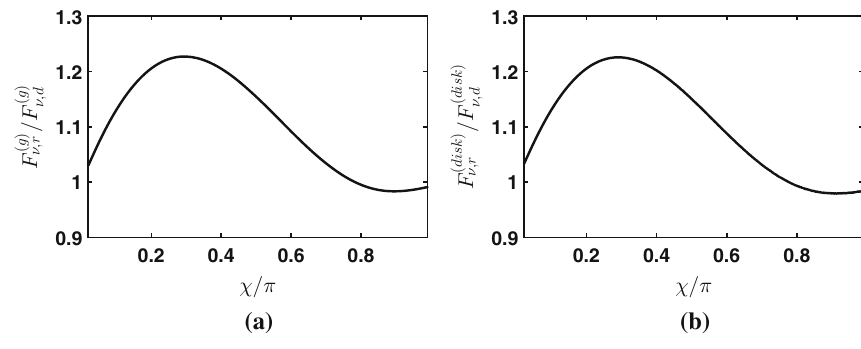
Fig. 7 The ratios of fluxes for the direct and retrograde scatterings versus χ/π